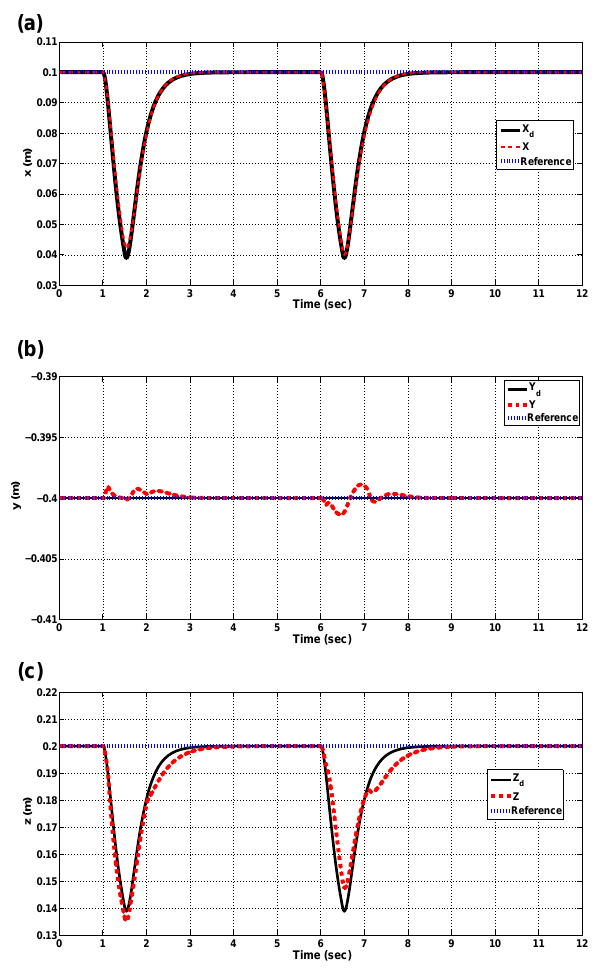
Figure 8. Cartesian position x (a) and y (b) and z (c) for K r = 12Nsm − 1 and K i = 30Nm − 1 ( Fx = Fz = 5N and Fy =